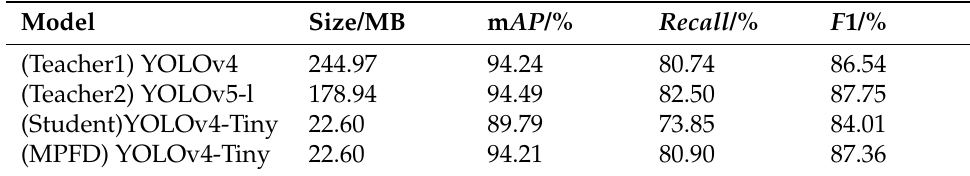
Figure 8. Validation set loss values. Table 3. Feature distillation training